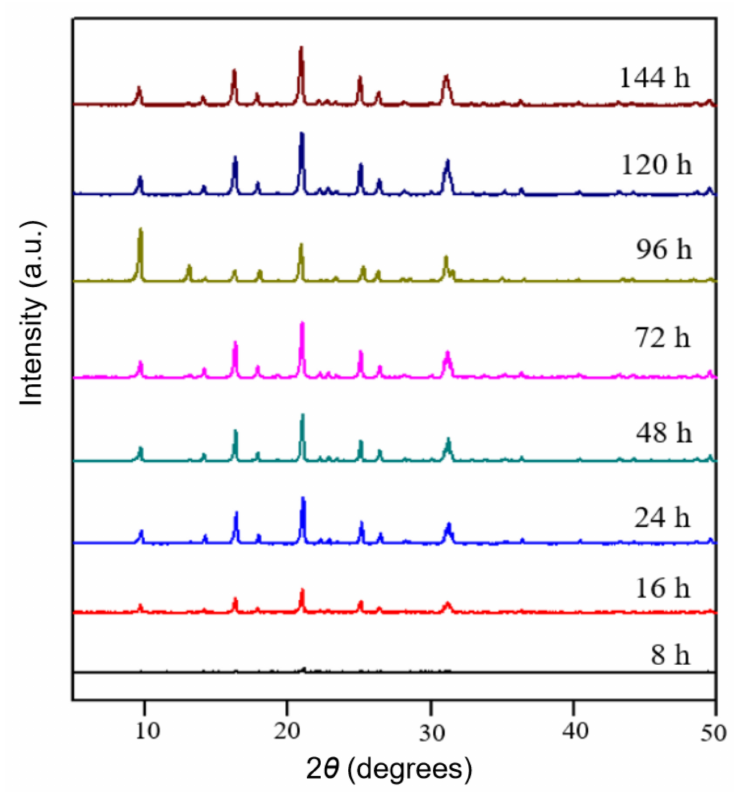
Figure 1. XRD patterns of samples prepared at various reaction